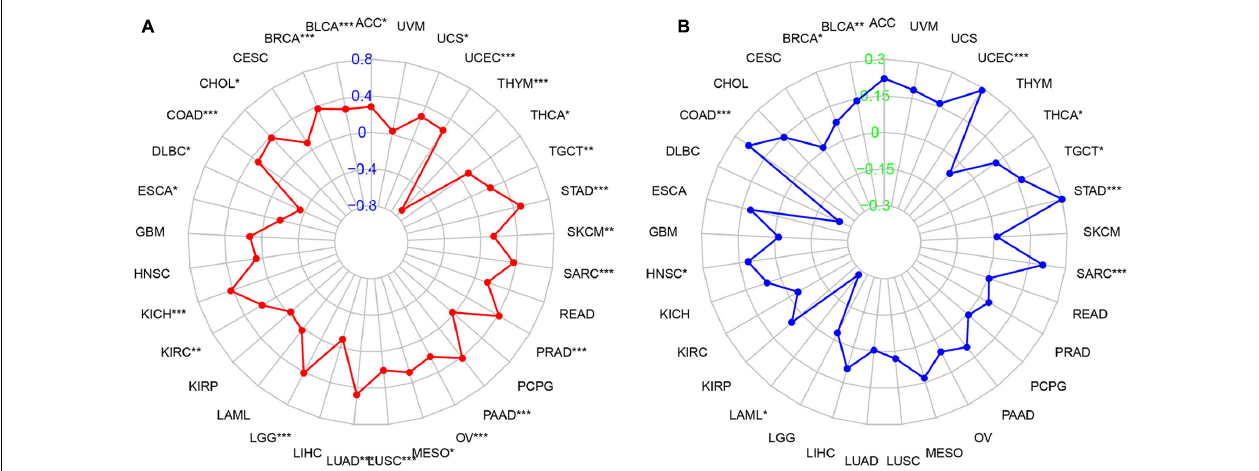
FIGURE 10 | Association between PIMREG expression and the tumor mutational burden (TMB) and microsatellite instability (MSI) in various cancer types. (A) Radar plot showing the relationship of PIMREG expression with TMB in pan-cancers. Red lines represent correlation coefficients and blue values represent ranges. (B) Radar plot showing the relationship of PIMREG expression with MSI in pan-cancers. The blue lines represent correlation coefficients and green values represent ranges. * p < 0.05, ** p < 0.01, and *** p <